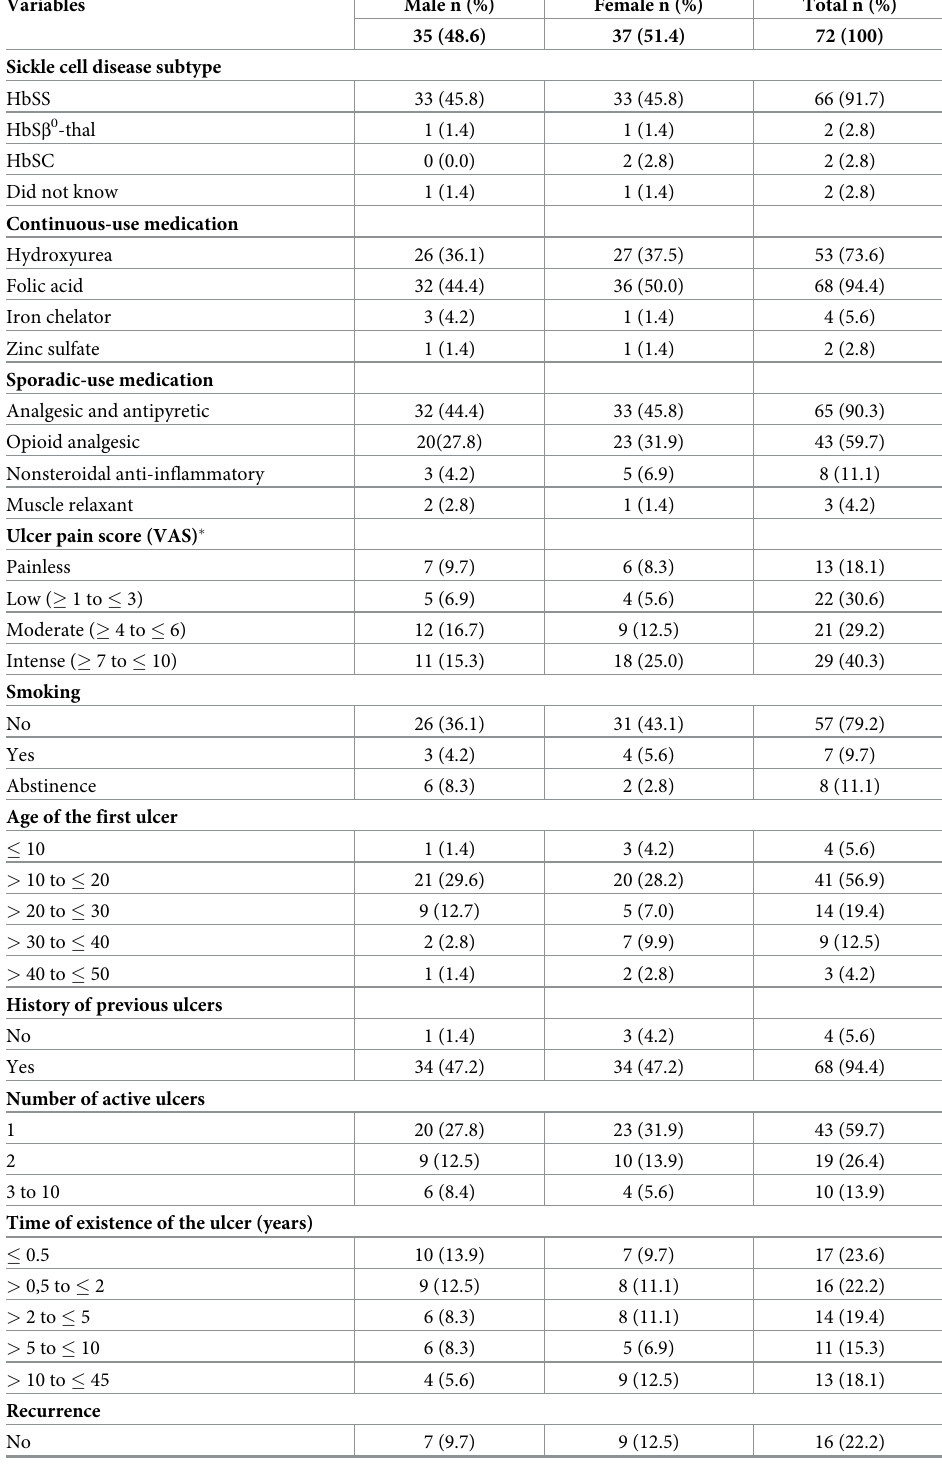
Table 4. Clinical variables, by sex (n =